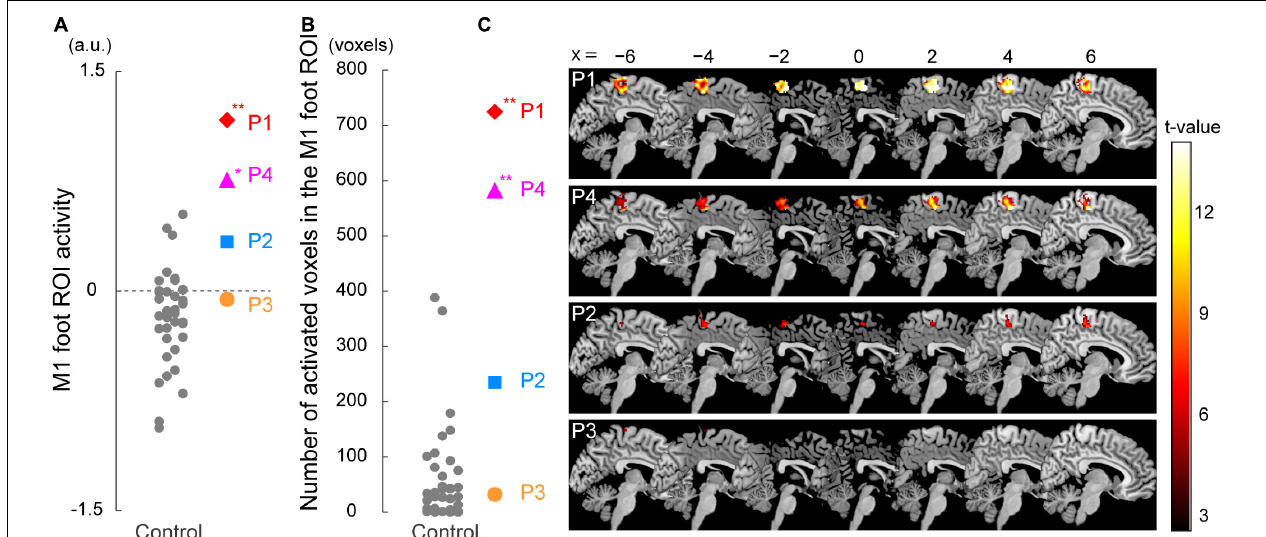
FIGURE 3 | Results from ROI analysis for functional data. (A) Individual M1 foot ROI activity during the bimanual task. A vertical axis indicates the mean value of the brain activity (parameter estimates) obtained from the ROI. Participants P1 and P4 showed significantly greater M1 foot ROI activity compared to the control participants. (B) The number of activated voxels having T-value greater than 2.61 (which corresponded to height threshold p < 0.005) within the M1 foot ROI in each participant. A vertical axis indicates the number of activated voxels. The number of activated voxels in participants P1 and P4, but not in P2 and P3, were significantly larger than those in the control participants. (A,B) Red diamonds, blue rectangles, orange circles, and pink triangles represent the data obtained from paraplegic participants P1, P2, P3, and P4, respectively. Gray dots represent the data obtained from the control participants. The plotted points for the control participants are horizontally jittered to avoid over-plotting. Asterisks indicate significant differences from the control data (** p < 0.001, * p < 0.05 with Bonferroni correction). (C) Voxels having T-value greater than 2.61 (height threshold p < 0.005) within the M1 foot ROI in each participant. Please note that participants are listed in order of greater number of activated voxels, from top to bottom. These voxels are superimposed on the sagittal slices (x = -6, − 4, − 2, 0, 2, 4, and 6) of the MNI standard brain. M1, primary motor cortex; ROI, region-of-interest; a.u. , arbitrary unit